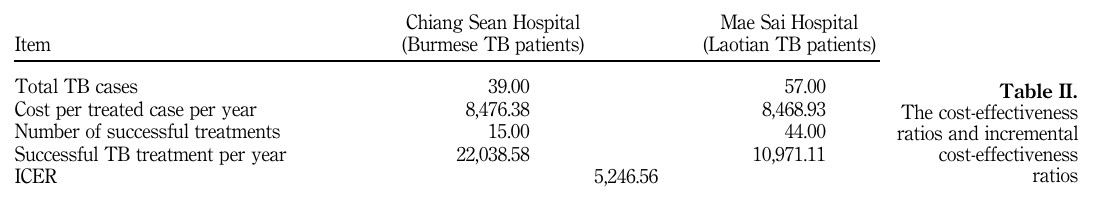
Table II. The cost-effectiveness ratios and incremental